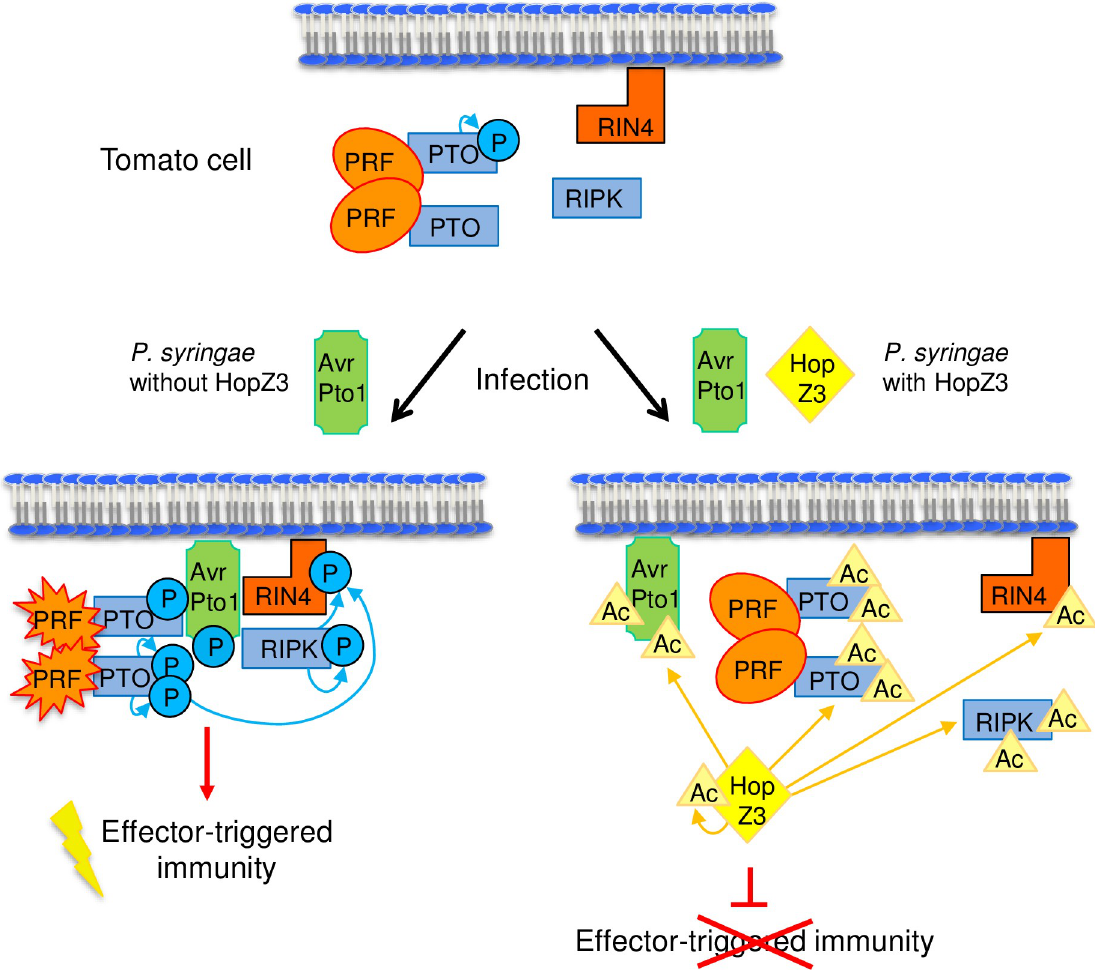
Fig 9. Model of HopZ3 disruption of PTO-mediated signaling in tomato. PTO and PRF are in a multimeric complex under basal conditions [23]; it is unknown whether RIN4 and/or RIPK are in a complex. AvrPto and RIN4 were shown to be associated with the membrane, but it is not known where the interactions occur. Upon infection with P . syringae containing AvrPto1 but not HopZ3, Psy AvrPto1 Psy becomes phosphorylated and binds to a PTO molecule, inhibiting its activity. Another molecule of PTO can autophosphorylate and transphosphorylate PTO bound to AvPto1 Psy . The AvrPto1 Psy -PTO interaction and phosphorylations cause PRF activation and initiation of effector-triggered immunity [23]. RIN4 interacts with AvrPto1 and may be phosphorylated by RIPK and/or PTO during Psy infection and contribute to signaling. In the presence of HopZ3, acetylation of AvrPto1 Psy , PTO, RIPK and RIN4 leads to reduced -PTO complex formation, ultimately resulting in disruption of effector-triggered phosphorylation and suppression of AvrPto1 Psy immunity.